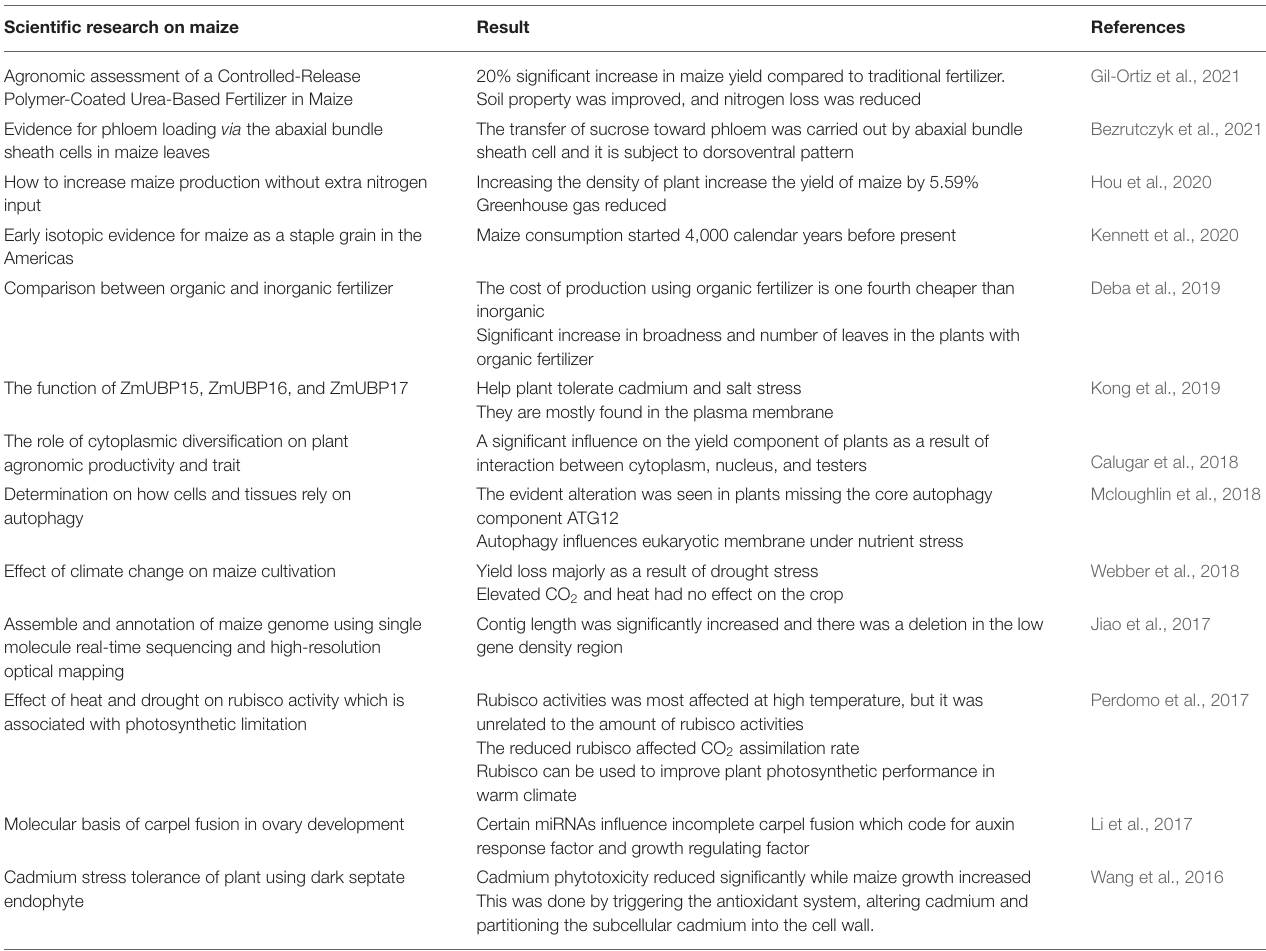
TABLE 1 | Significant research findings related to the study of